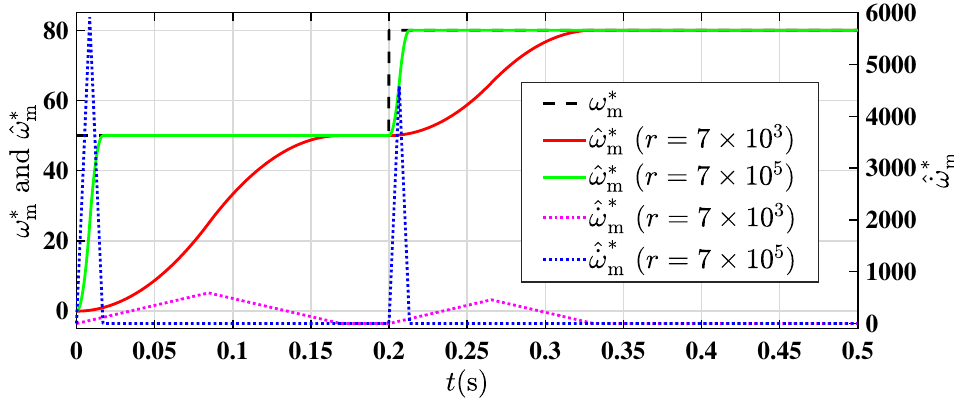
Figure 4. The output signals of presented TD with r = 7 × 10 3 and r = 7 × 10 5 .